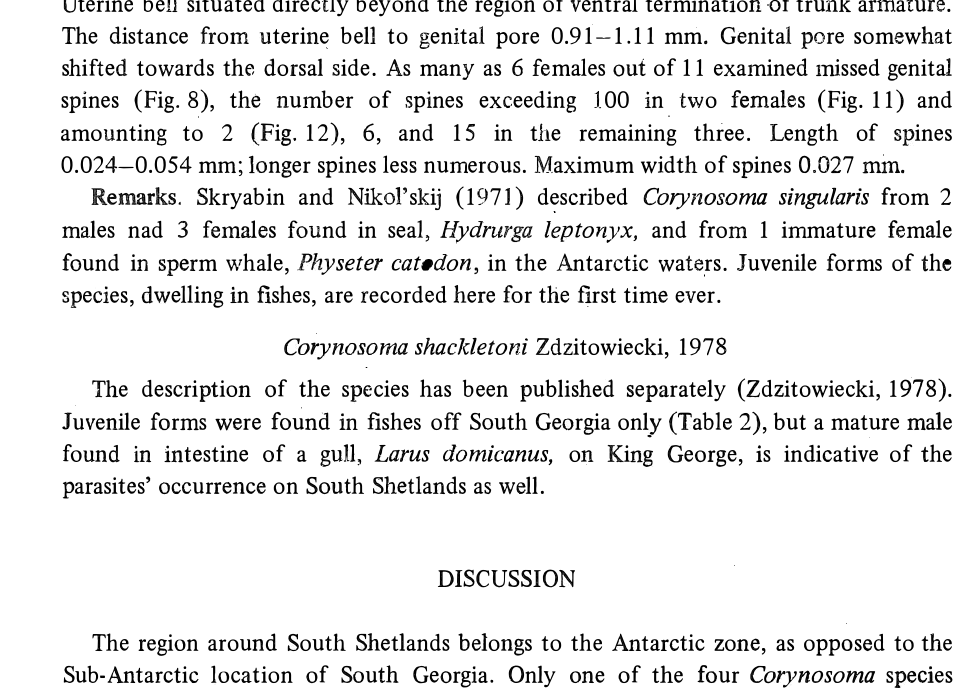
Fig. 12. C01ynosoma singularis, a female genital pore region with two genital